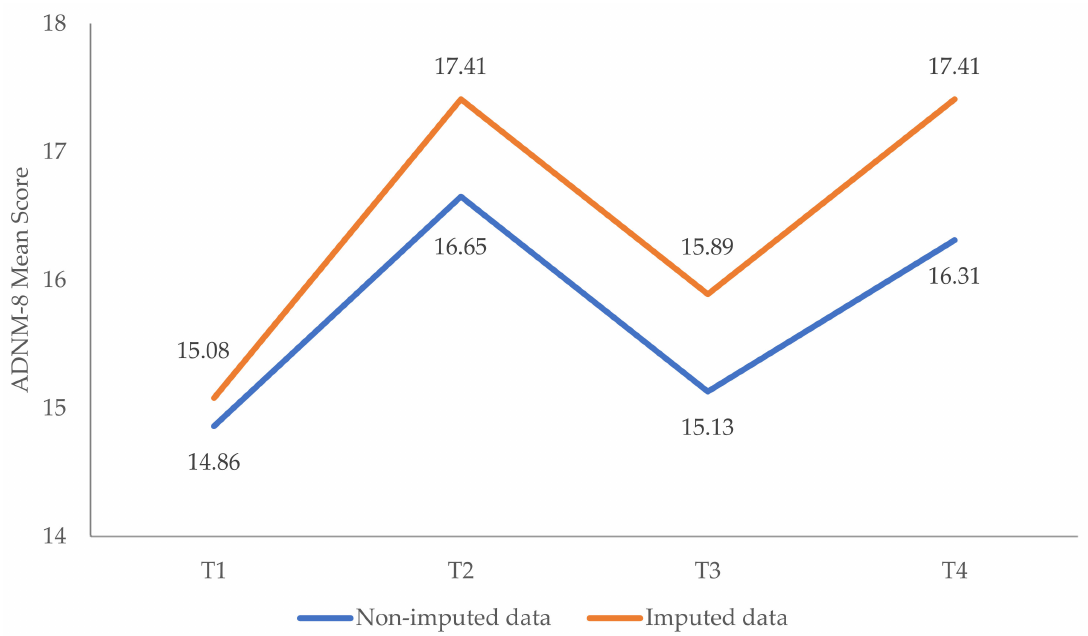
Figure A1. Changes in symptoms of adjustment disorder (ADNM-8) over time: imputed vs.